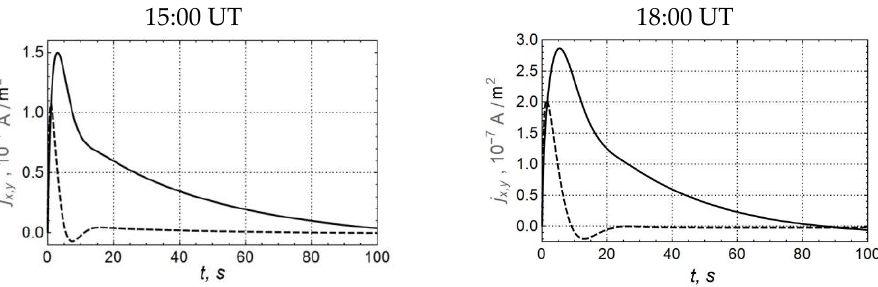
Figure 6. Time dependence of the telluric current density components. 𝑗 𝑥 — solid line, 𝑗 𝑦 — dotted line.